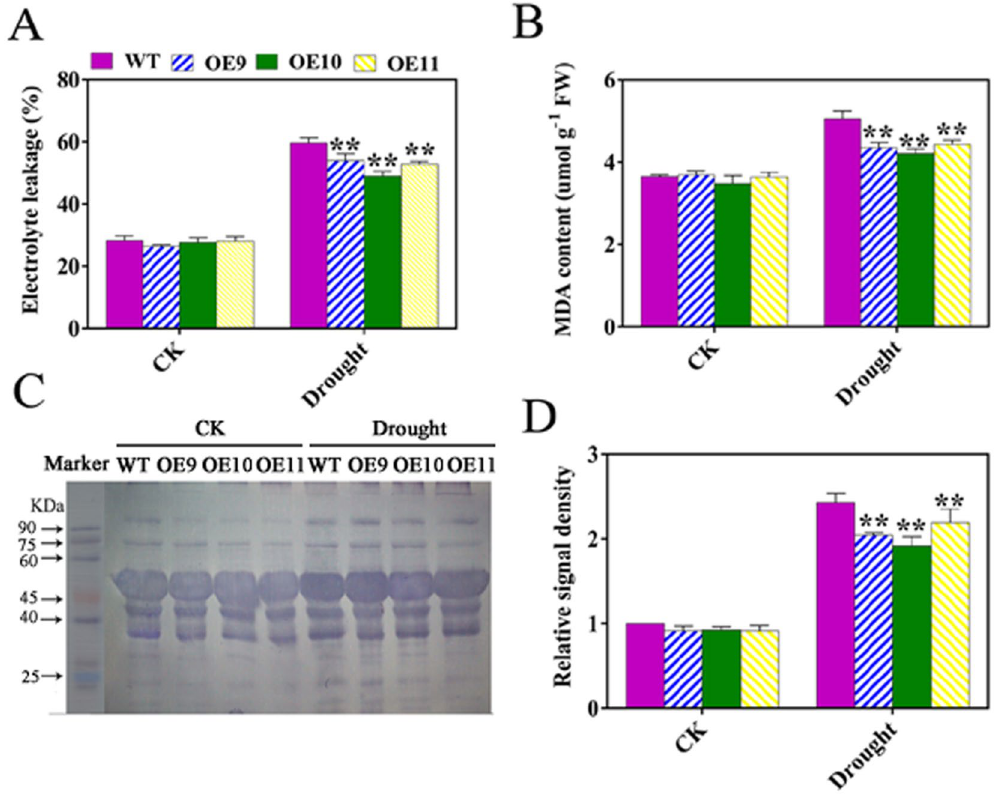
Figure 5. Influence of drought stress on electrolyte leakage, malondialdehyde (MDA), and protein carbonylation levels in the OE and WT plants. ( A ) Electrolyte leakage. ( B ) MDA content. ( C ) Protein carbonylation levels. ( D ) Relative signal density of protein carbonylation levels observed in ( C ). The experiments were repeated three times and the bars indicate SEs. * and ** indicate significant differences at P < 0.05 and P < 0.01 among the three overexpression lines and the WT